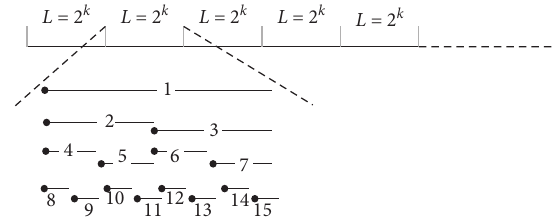
Figure 4: Example of the labeling on a predicate interval. The unit- length is L � 2 k . We divide the interval into unit-length segments. In every segment, we build 2 k − 1 SIUs. The local ID of all these SIUs is from 1 to 2 k +1 −